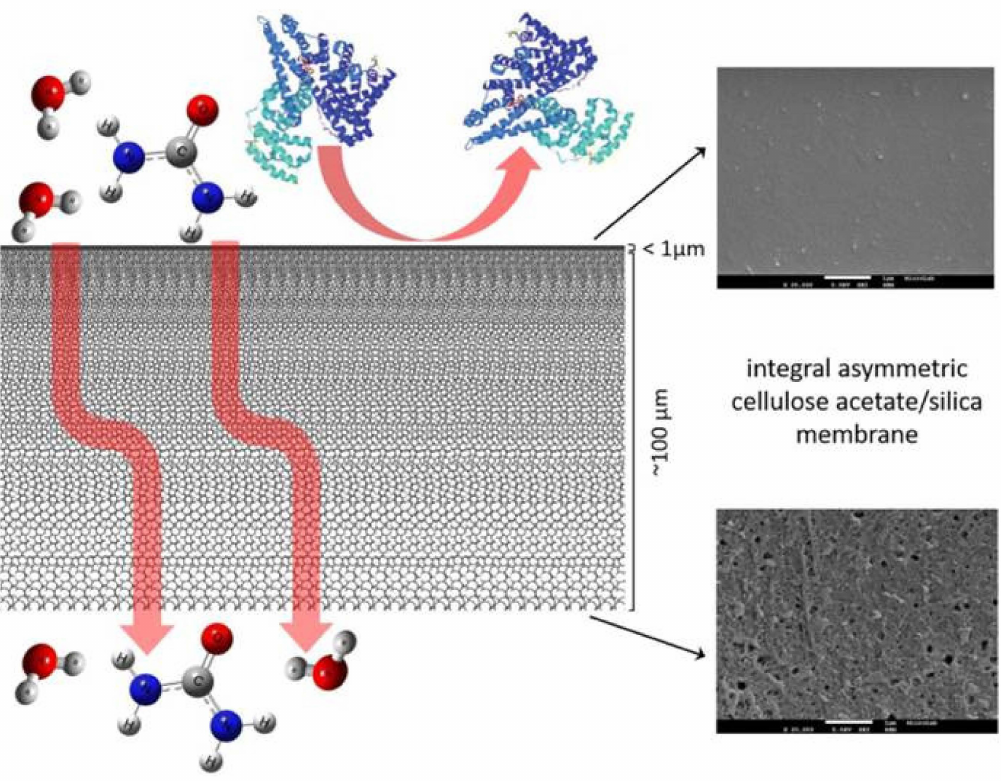
Figure 4. Monophasic hybrid cellulose acetate/silica (CASiO 2 ) integrally skinned membranes with tailored hemocompatible surfaces. Reprinted with permission from Faria et al. [153] Copyright 2020, Springer